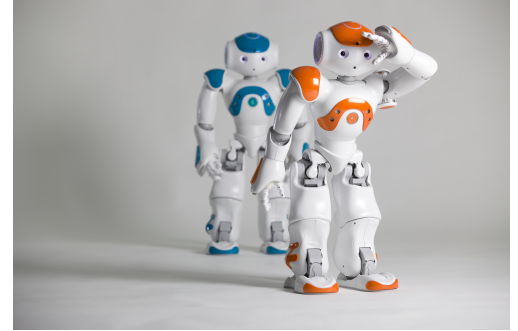
Figure 11. Nao looks at its futures